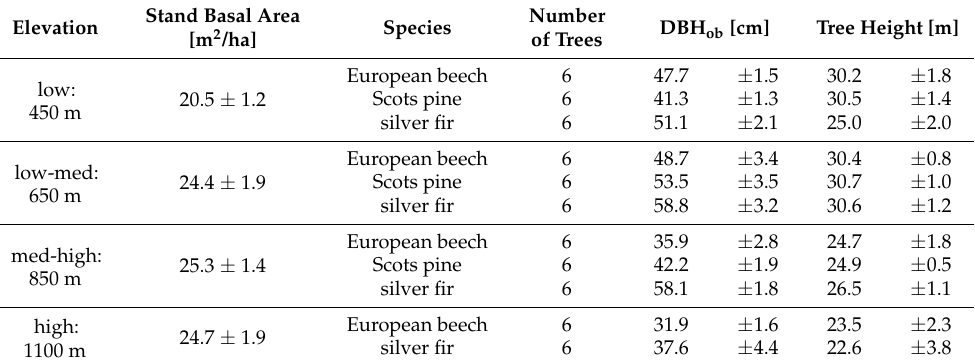
Table 1. Average stand basal area, sample sizes, mean diameter at breast height (DBH ob ) and mean tree height with corresponding standard errors at each elevation.